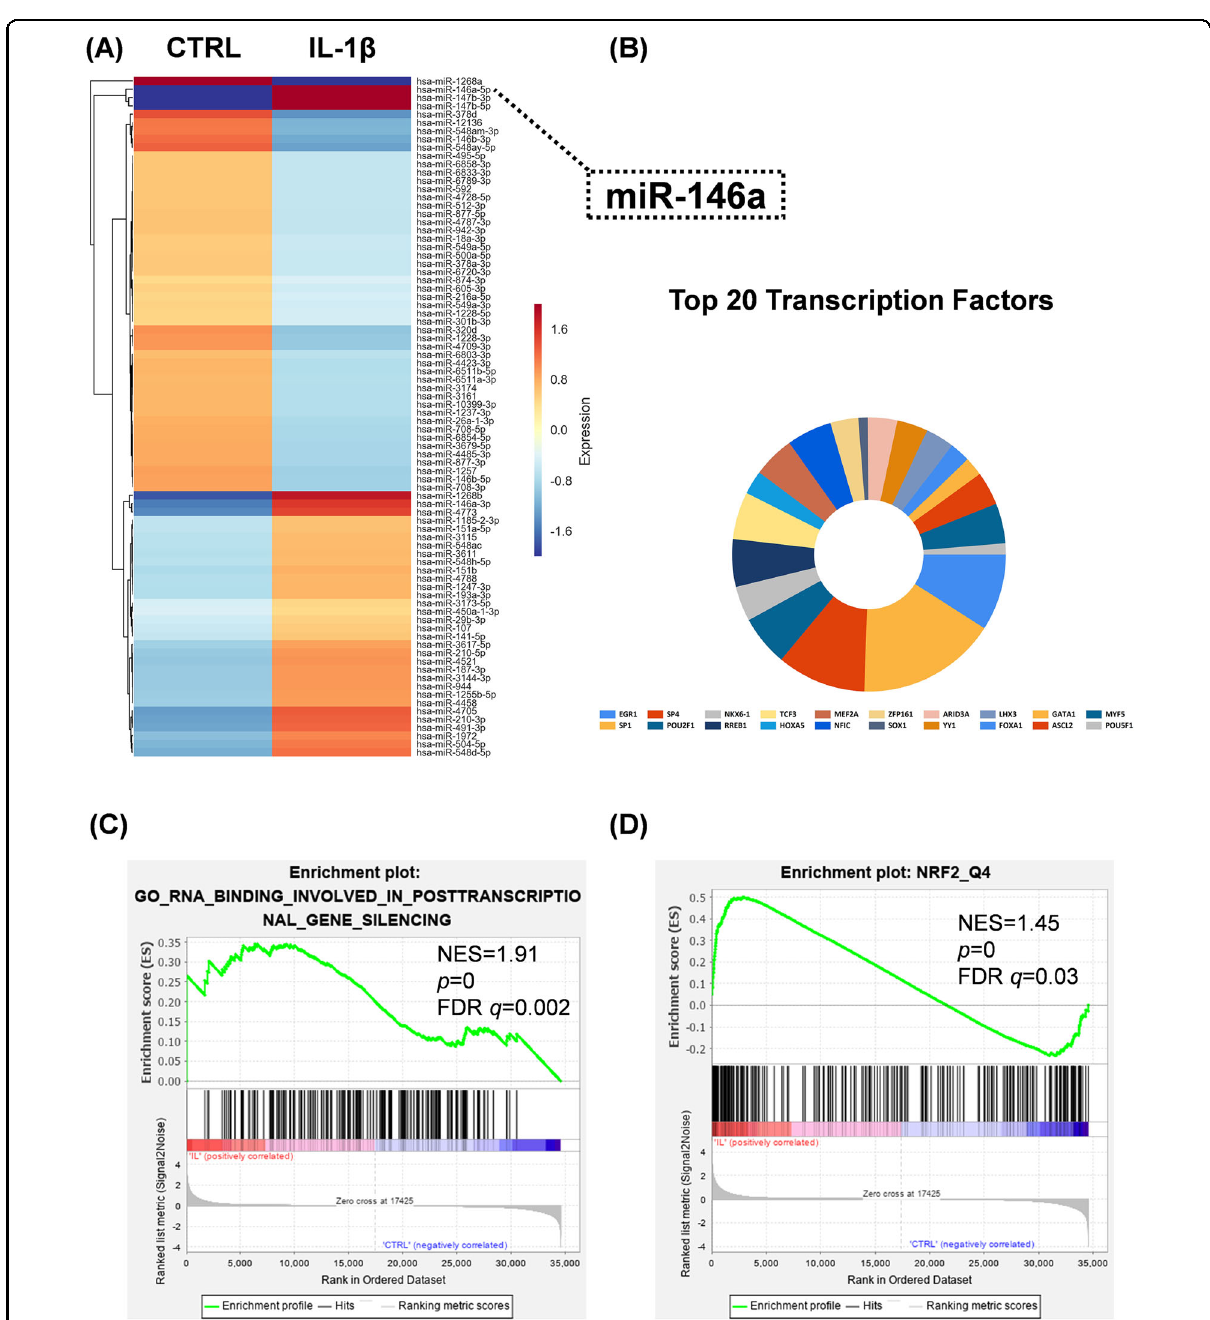
Fig. 5 Effect of IL-1 β on the expression of differentially expressed miRNAs in chondrocytes. A Heat map for the differentially expressed miRNAs in IL-1 β -treated and control chondrocytes. The color bars on the right of the map indicate gene expression level; red denotes high expression whereas blue denotes low expression, relative to the median. B Enrichment analysis of differentially expressed miRNAs in IL-1 β -treated and control chondrocytes. The area of the colored region corresponds to the percentage of enriched genes. C – D GSEA enrichment analysis of differentially expressed miRNAs and mRNAs in IL-1 β -treated and control chondrocytes. C Enrichment analysis of posttranscriptional gene silencing mRNAs. D Enrichment analysis of NRF2 transcription